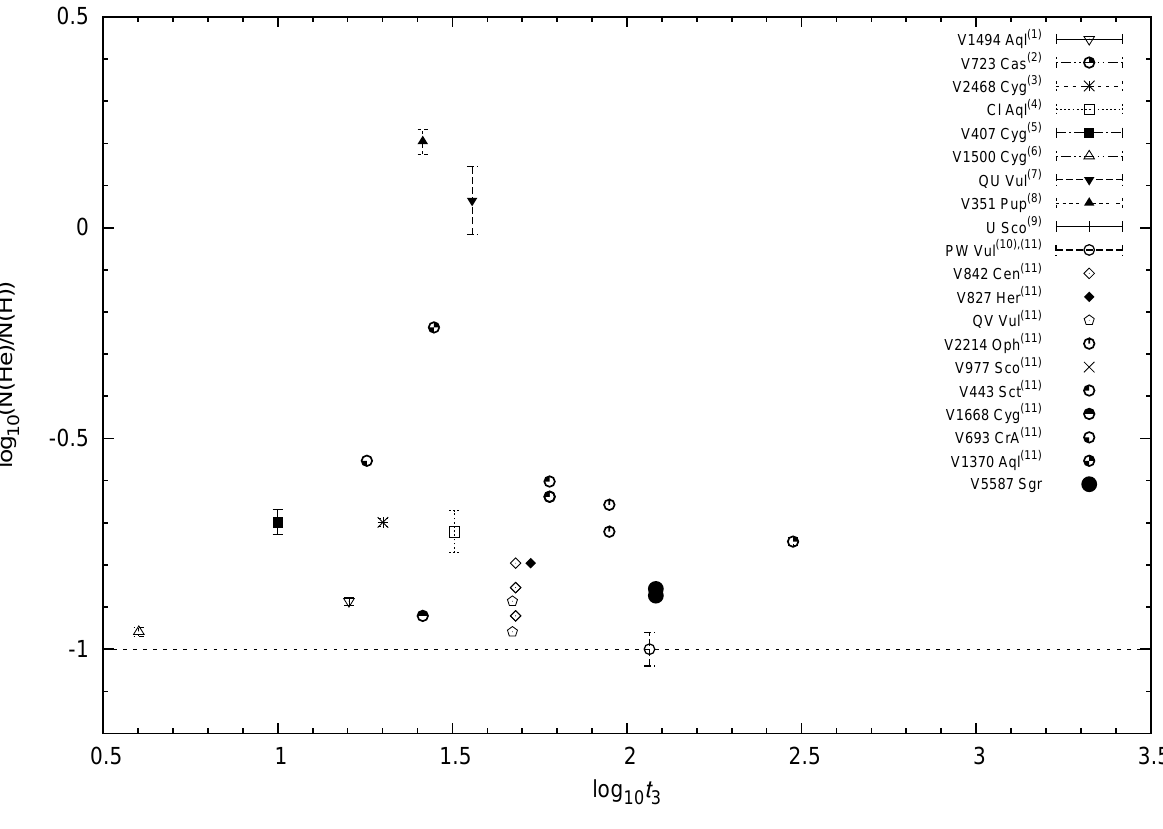
Figure 5: The helium abundance of 20 novae. References: (1) Iijima & Esenoglu (2003); (2) Iijima (2006); (3) Iijima & Naito (2011); (4) Iijima (2012a); (5) Iijima (2012b); (6) Ferland (1978); (7) Schwarz (2002); (8) Saizar (1996); (9) Iijima (2002); (10) Schwarz et al. (1997); (11) Andre¨a et al.